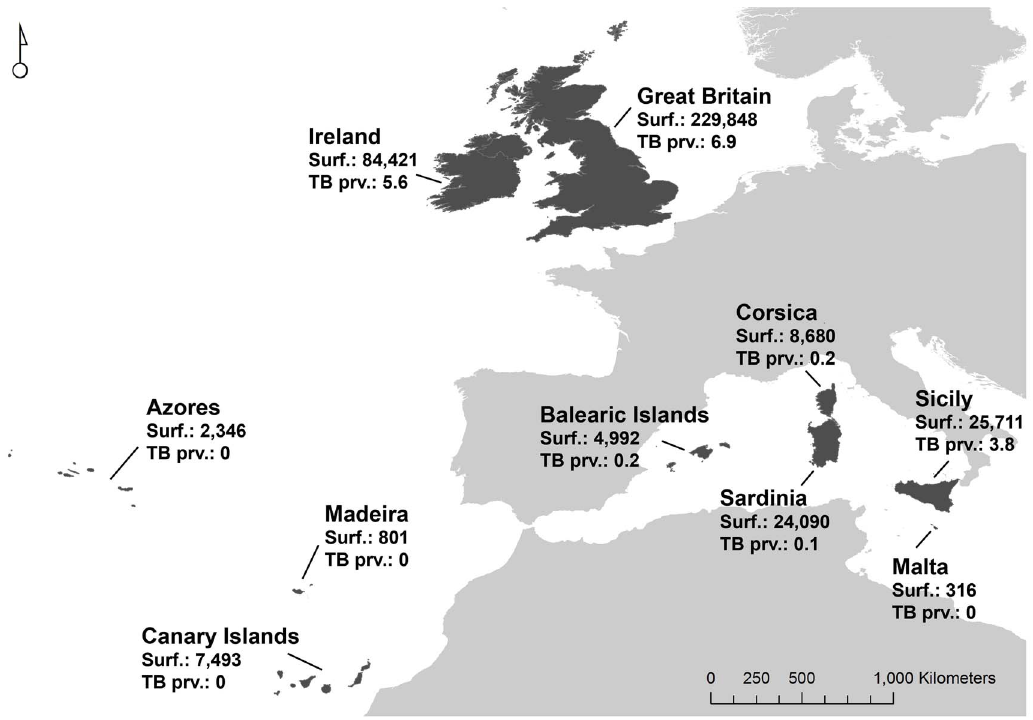
Figure 1. Islands and archipelagos considered in the study. Location, surface and cattle herd tuberculosis prevalence (see Table 1 for data sources) in the study islands and archipelagos are shown.